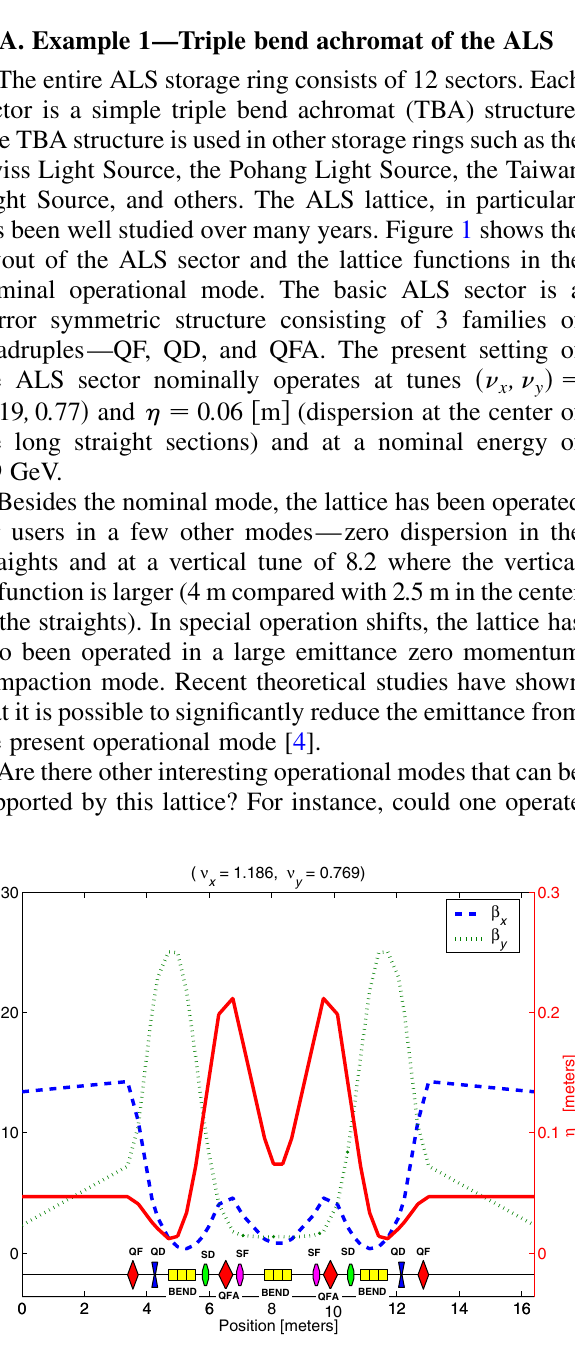
FIG. 1. (Color) Lattice of one of 12 ALS sectors and associated , (cid:3) , and (cid:2) ) in the nominal operational lattice functions ( (cid:3) x y x mode starting from the center of one straight section and going to the center of the following straight section.